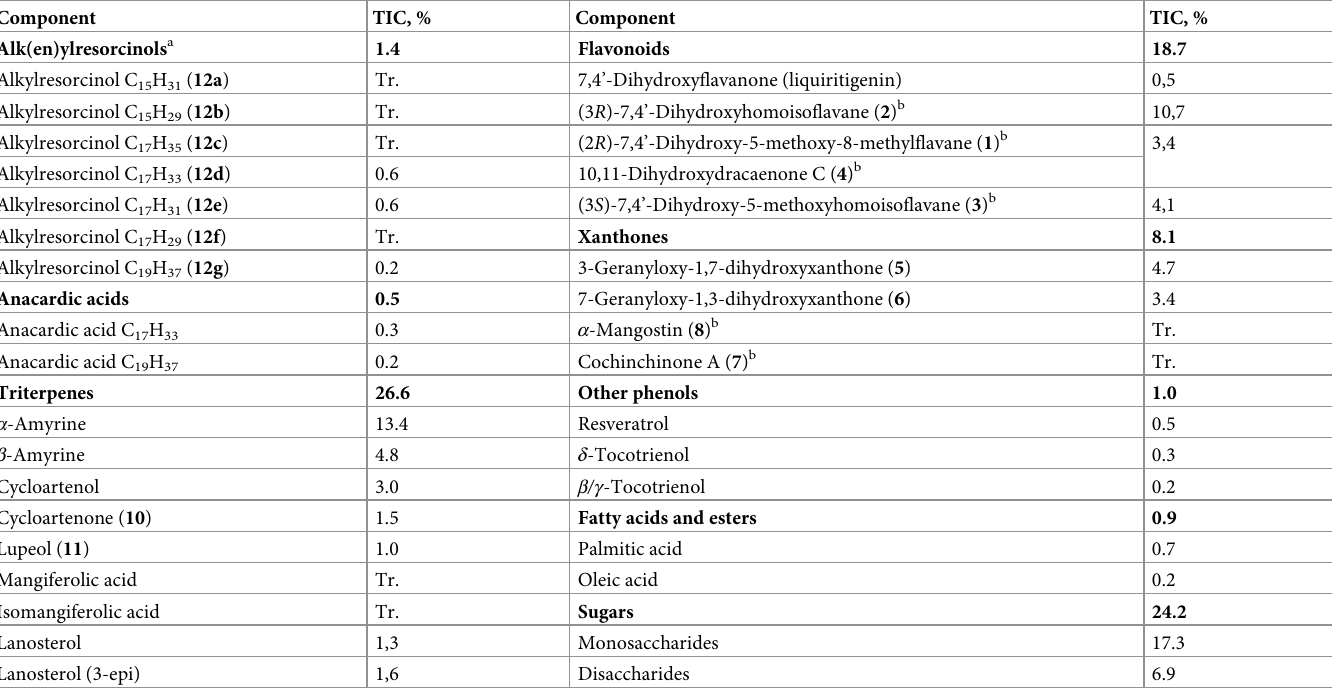
of NMR (1D and 2D) experiments, optical rotation data, and literature data comparison. Mix- ture 12 was additionally characterized and confirmed by GC/MS as consisting of resorcinols 12a-g . Among the isolated compounds, six ( 1 – 6 ) were found in propolis for the first time. Table 1. Constituents identified in 70% ethanol propolis extract by GC/MS (TMS